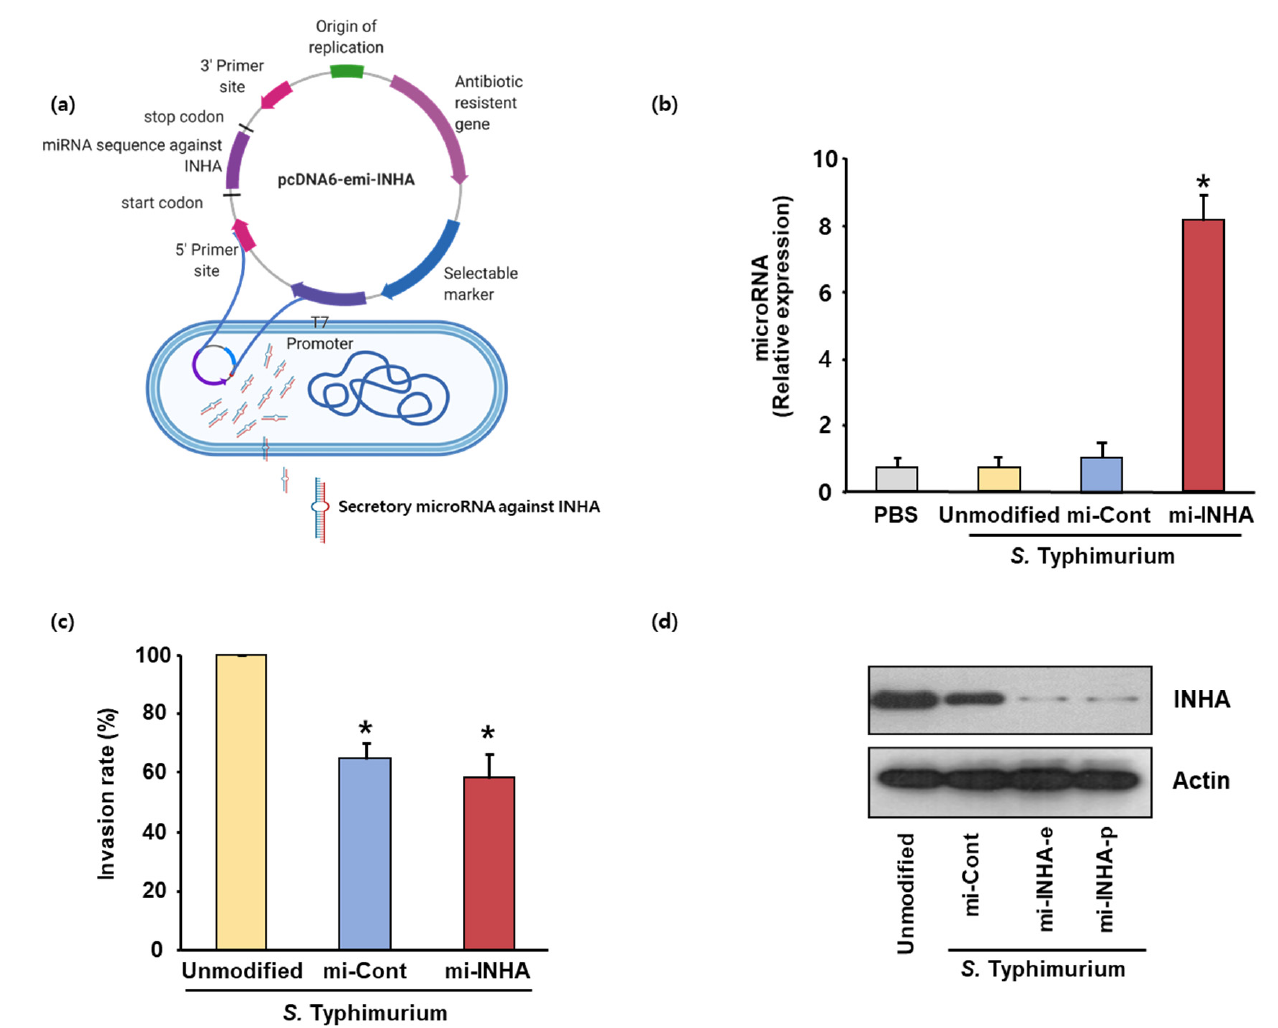
Figure 2. Construction of S. Typhimurium expressing microRNA against INHA gene. ( a ) Schematic representation of modified pcDNA6.2-GW/EmGFP-miR vector expressing the mi-INHA. ( b ) To validate the production of mi-INHA, the expression of microRNA was measured in bacterial cells. MicroRNA from genetically engineered S. Typhimurium were analyzed using RT-qPCR. ( c ) B16F10 mouse melanoma cells were infected with the indicated S. Typhimurium at a multiplicity of infection (MOI) of 500 for 1 h (for invasion assay). The invasion rate of mouse melanoma cells by the unmodified S. Typhimurium was set to 100%, and the relative internalization levels were normalized against those of unmodified S. Typhimurium . The data represent the mean ± SEM of three independent experiments (* p < 0.05 vs. unmodified S. Typhimurium -treated samples; Student’s t -test). ( d ) B16F10 cells were infected with unmodified S. Typhimurium or genetically modified S. Typhimurium expressing negative control mi-RNA or mi-INHA for 48 h. To validate INHA knockdown in cancer cells after infection with recombinant Salmonella , the expression of mouse INHA was measured. Western blot normalized to β -actin was added as supplementary material (Supplementary Figure S1). The cell lysates were subjected to Western blot analysis with anti-INHA or anti-actin antibodies.